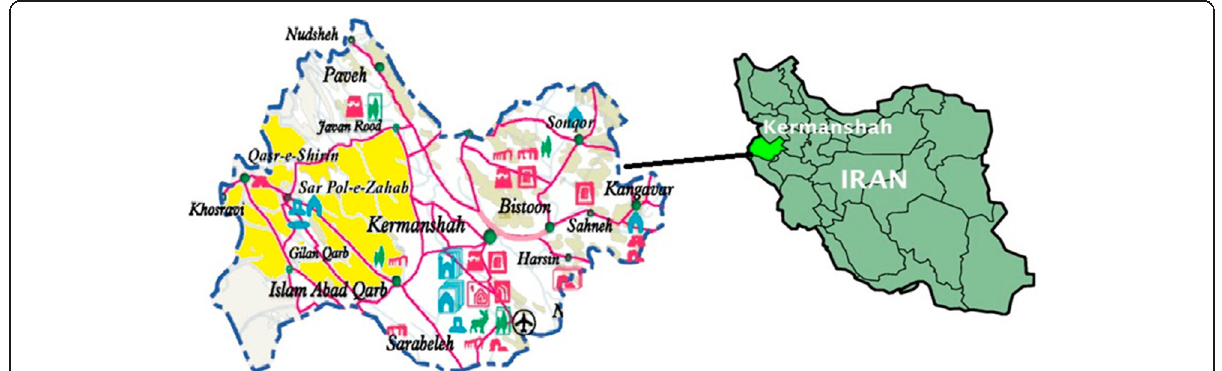
Fig. 1 The location of the tropical areas of Kermanshah province in Iran, marked in